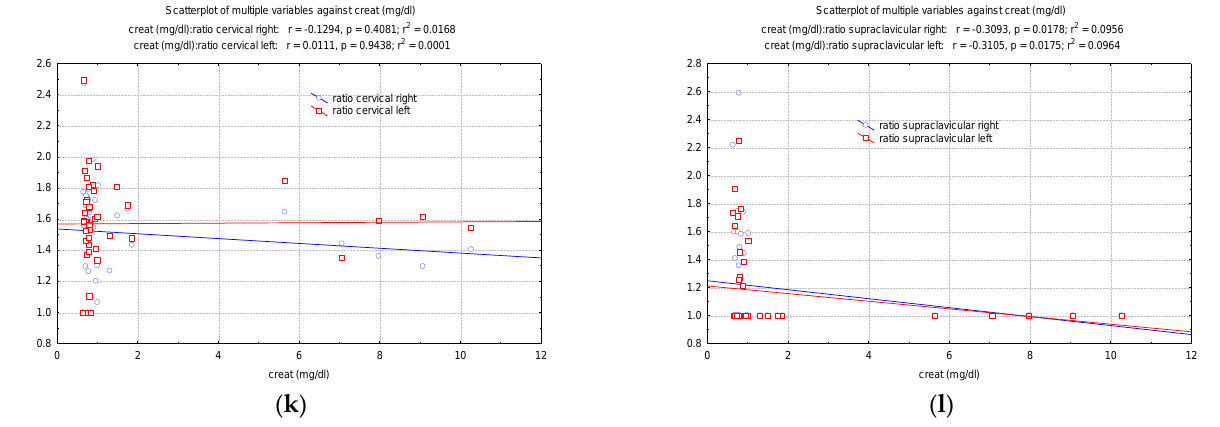
Figure 5. Pearson correlations between the biochemical/blood analysis ( a , b ) Ca, ( c , d ) vit D, ( e , f ) Phosphorus, ( g , h ) Mg, ( i , j ) uree, ( k , l ) creat and the values of (total counts/pixels) BAT /(total counts/pixels) non-BAT ratio. The values of (total counts/pixels) BAT /(total counts/pixels) non-BAT ratio in the right and left cervical localization, in addition to the right and left supraclavicular regions, did not show significant differences with the scintigraphic diagnosis (parathyroid adenomas and hyperfunctional PGs) ( p > 0.05) (Figure 6). Box Plot of multiple variables grouped by Scintigraphy ratio cervical right: F(1,54) = 0.0443, p = 0.8342 ratio cervical left: F(1,54) = 0.0468, p = 0.8295